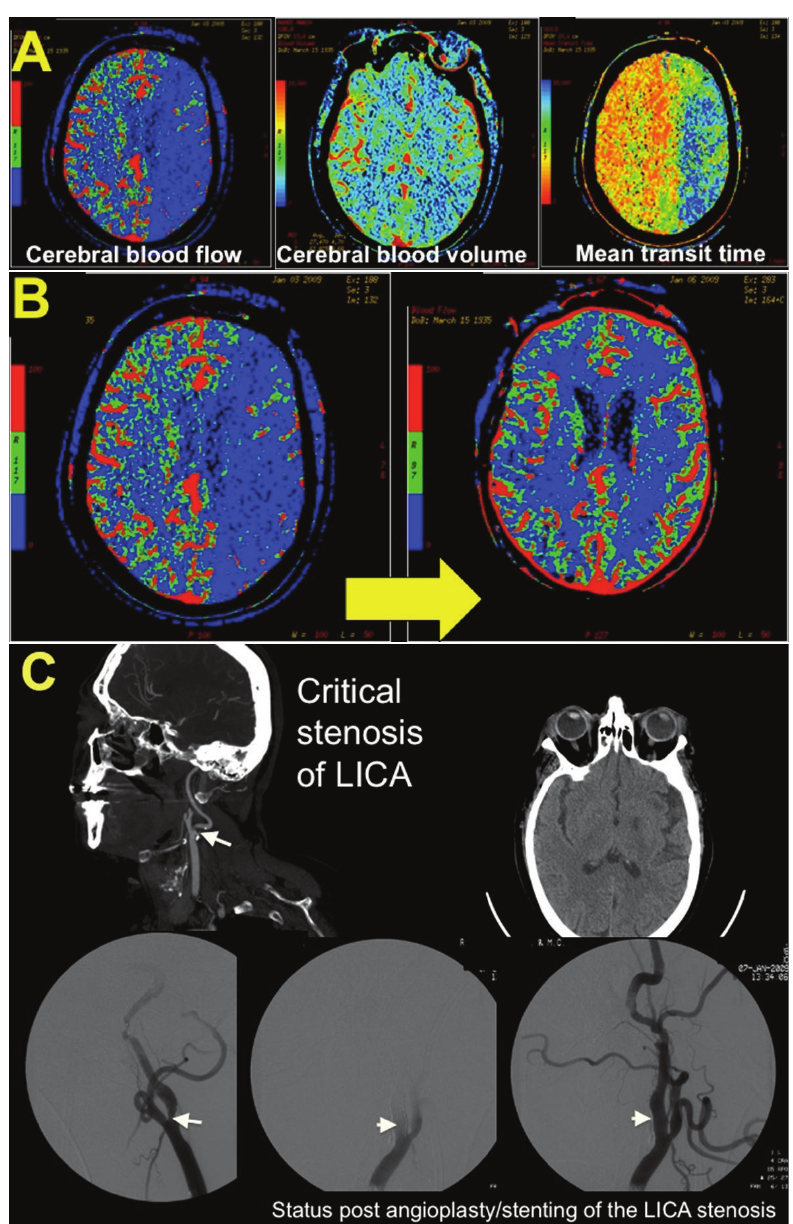
Figure 1: A 73 year-old woman underwent intramedullary fixation of a fractured right femur. She received 2 doses of Hydralazine for elevated BPs the evening after surgery, resulting in a decline in her SBP from 190 mmHg to 110mmHg. The following morning, she was noted to be confused, nonverbal, and paretic in her right arm. An inpatient stroke code was called, and a CT/CTA/CTP was obtained. The perfusion imaging revealed a prolonged MTT, decreased CBF, and relatively preserved CBV within the left hemisphere suggestive of ischemia within this territory (A). She was transferred to the ICU for further management. (B) diagrams the resolution of these perfusion deficits with a marked improvement in CBF following aggressive intravenous fluid resuscitation, blood transfusion for anemia, and BP augmentation with pressors. This was accompanied by a significant clinical improvement as well. Her CTA neck revealed the etiology of her stroke to be a critical stenosis of her left internal carotid artery (C); she underwent angioplasty and stent placement and ultimately had minimal residual symptoms in the form of naming and paraphasic errors. There was no hemorrhagic transformation post-induced hypertension or